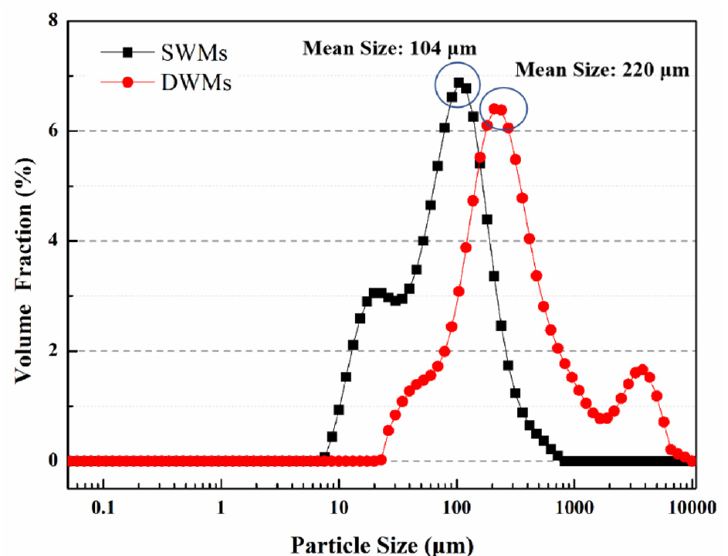
Figure 5. Particle size distributions of SWMs and DWMs.